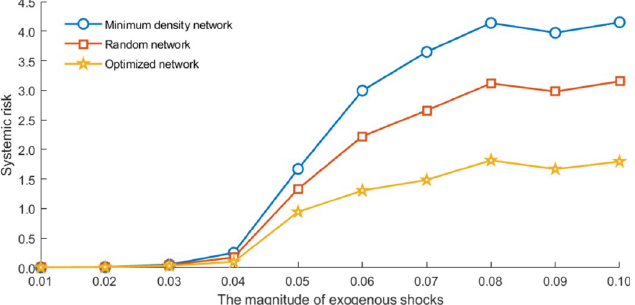
Fig 17. The results on different network topologies for changing the magnitude of exogenous